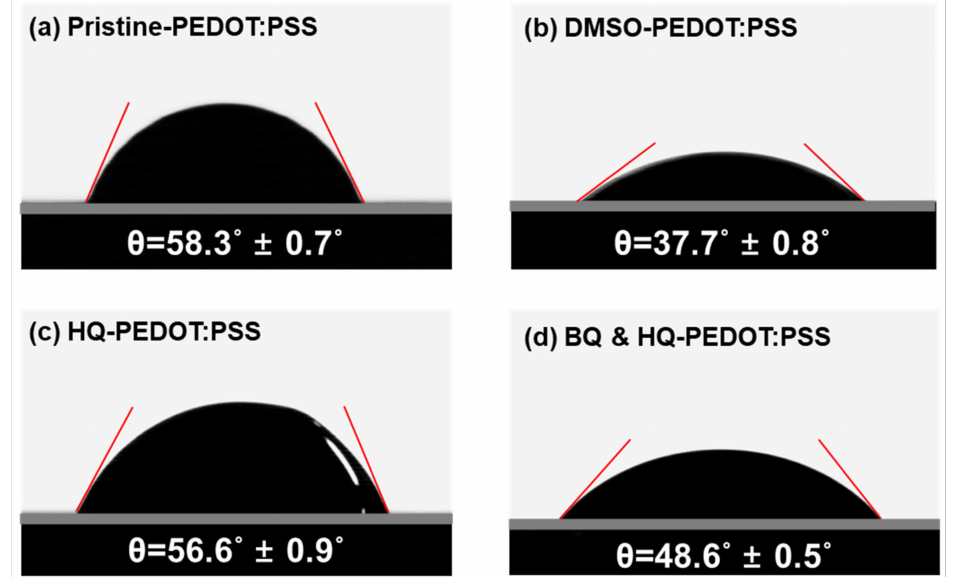
Figure 10. Measured contact angles of ( a ) pristine-, ( b ) DMSO-, ( c ) HQ-PEDOT:PSS on the native oxide formed Si surface, and ( d ) HQ-PEDOT:PSS on the BQ treated Si